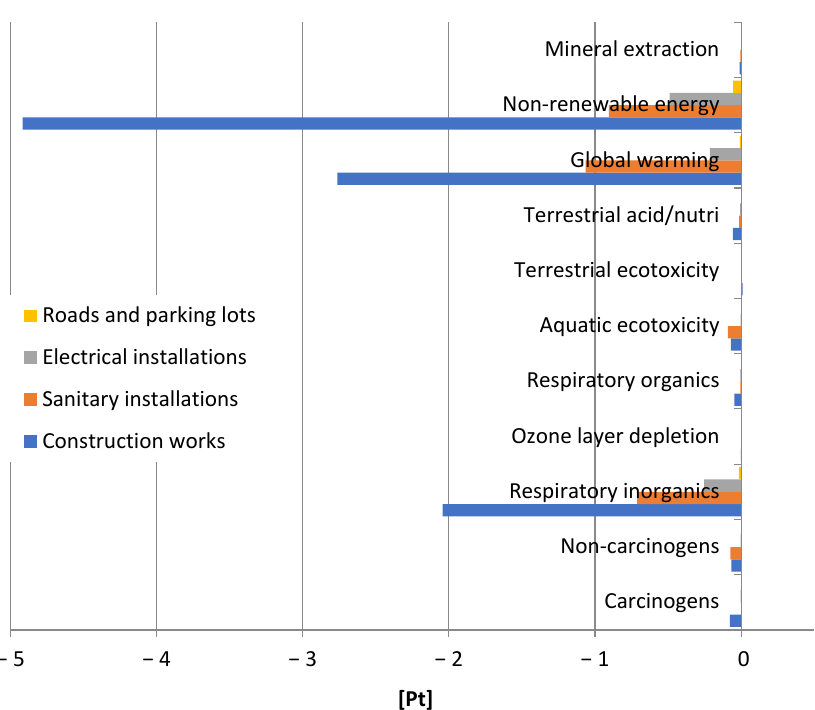
Figure 14. The results of grouping and weighing the environmental consequences occurring at the post-use development stage (in the form of recycling) of the research object by thirteen impact categories and groups of installations.